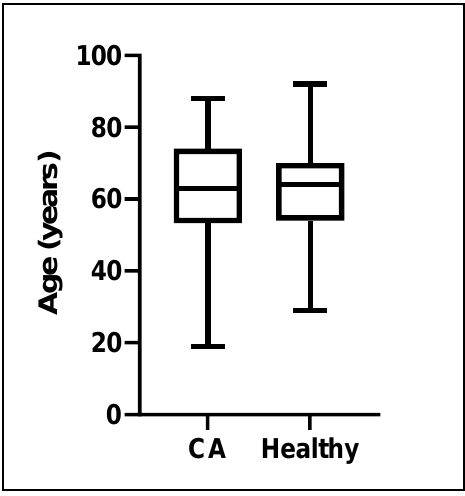
15 of 17 Figure A1. Single radial enzyme diffusion ( SRED) assays were analyzed using ImageJ. Per sample, a degradation index was calculated based on circumference (big red circle) and background-cor- rected intensity of the digested area, excluding the well (filled small circle). Representative SRED assays of three different samples with low, intermediate, and high DNase activity [mU/mL] are shown.